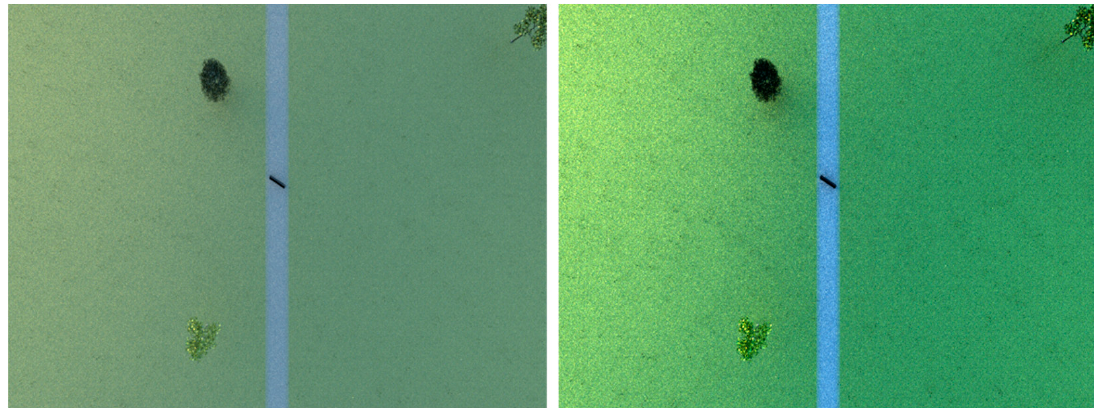
Figure 4. Comparison of γ = 0.5 ( left ) to γ = 1.0 ( right ).